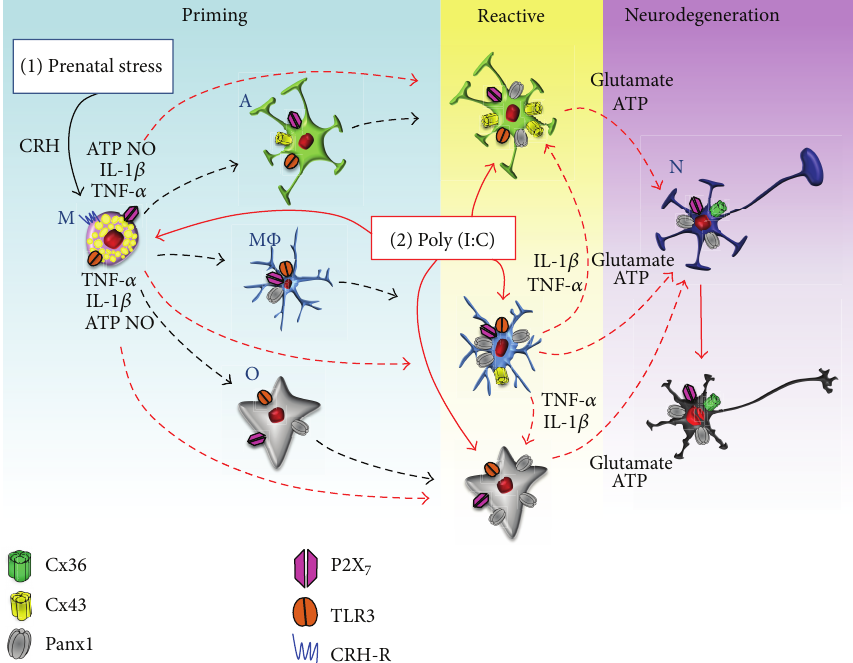
Figure 2: Model of the involvement of mastocytes and microglia in neuroinflammatory responses and potentiation of their responses by stress. Stress increases the levels of CRH and glucocorticoids which are critical players in stress-induced mastocytes (M) degranulation and potentiation of glial inflammatory responses (sensibilization). Furthermore, perinatal infections, particularly those of viral etiology (poly (I:C)), are frequent and have been associated with diverse alterations of CNS. Mastocytes and microglia (M Φ ) express toll-like receptor 3 (TLR3). Activated microglia and mastocytes increase the hemichannel activity in reactive astrocytes (A) and oligodendrocytes (O). Both activated microglia and astrocytes release ATP and glutamate that induce neurodegeneration through the activation of P2X 7 receptors and Panx1 channels in neurons (N) (neurodegeneration) (modified from Orellana et al., 2011)